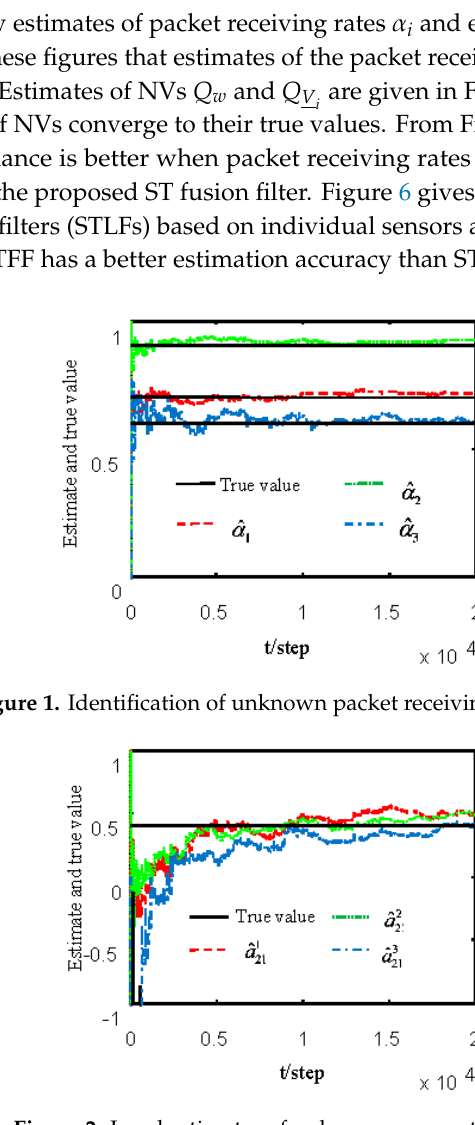
Figure 3. Identification of noise variance Figure 4. Identification of noise variances